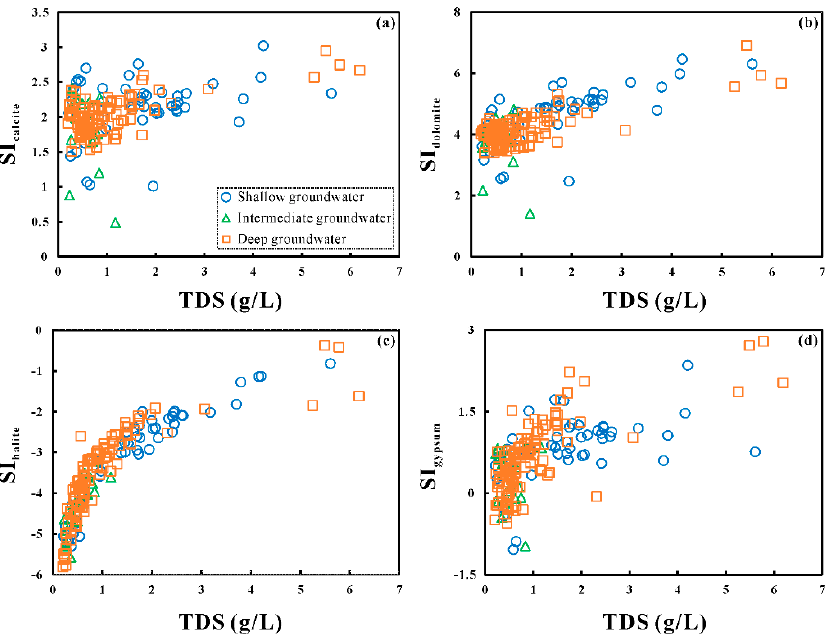
Figure 8. Scatter plots of TDS and four major minerals saturation index in groundwater (( a ) calcite, ( b ) dolomite, ( c ) halite, and ( d ) gypsum).